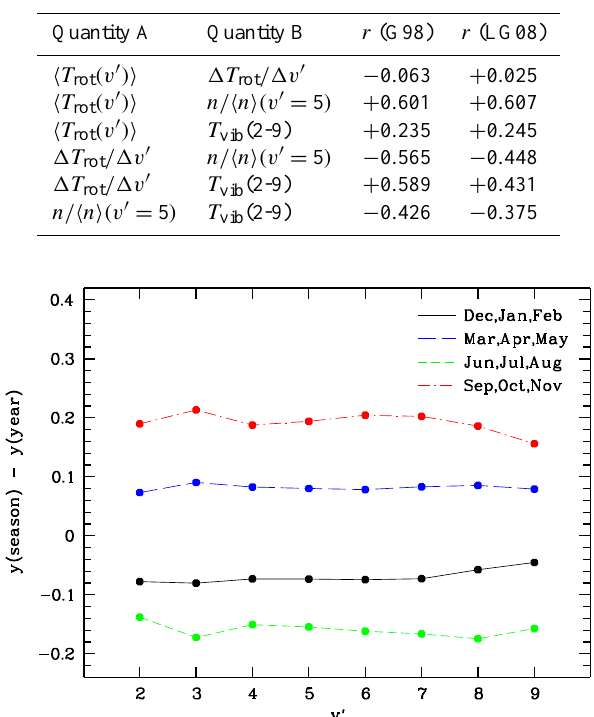
Table 2. Correlation coefficients r for different quantities derived from the individual observations by means of G98 and LG08 line parameters.